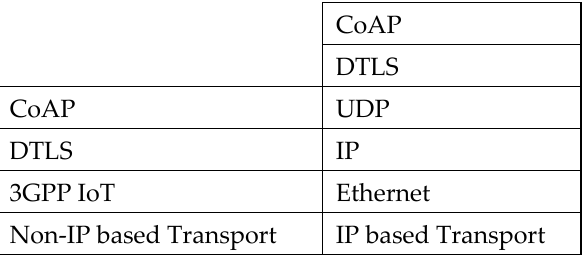
Figure 3. IP and non-IP-based transport.